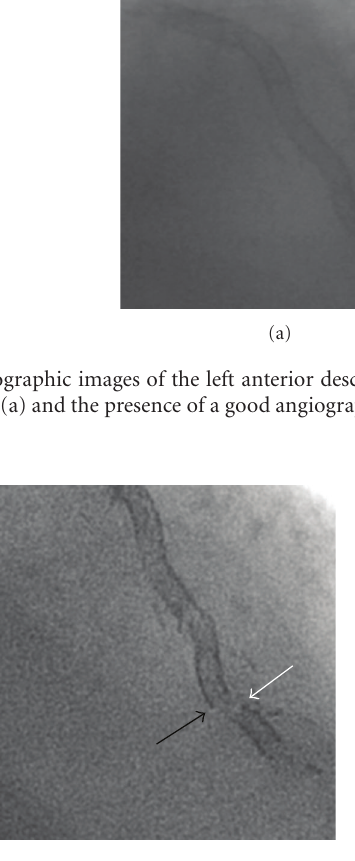
Figure 6: Complete Endeavor stent fracture of the distal left ante- rior descending coronary